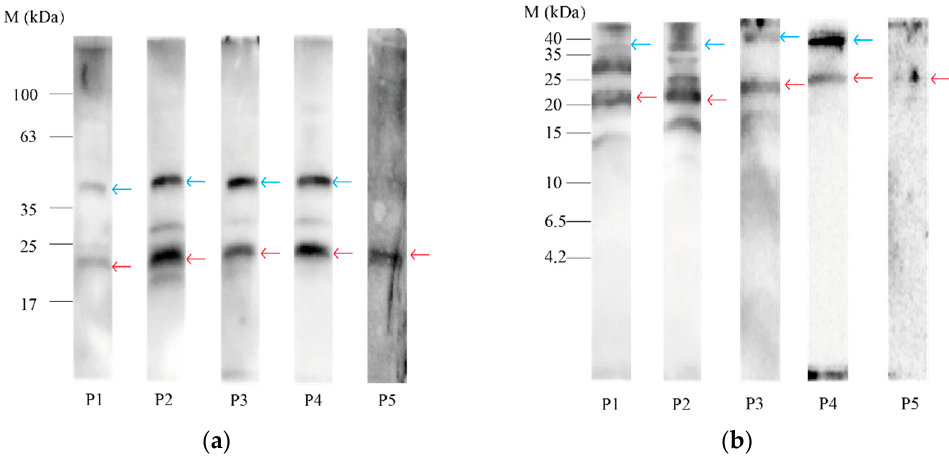
Figure 3. Immunoblot analysis of the serum IgE from five patients with allergy to pitaya (P1~P5) binding to red-fleshed pitaya seeds protein extraction. Approximately 20 kDa of IgE protein bands showing reactivity are marked with red arrows, approximately 40 kDa of IgE protein bands showing reactivity are marked with blue arrows: ( a ) immunoblot analysis after protein separation of red-fleshed pitaya seed extracts on 4~20% Tris–Gly–SDS polyacrylamide gels; ( b ) immunoblot analysis after protein separation of red-fleshed pitaya seed extracts on 16.5% Tris–tricine polyacrylamide gels.